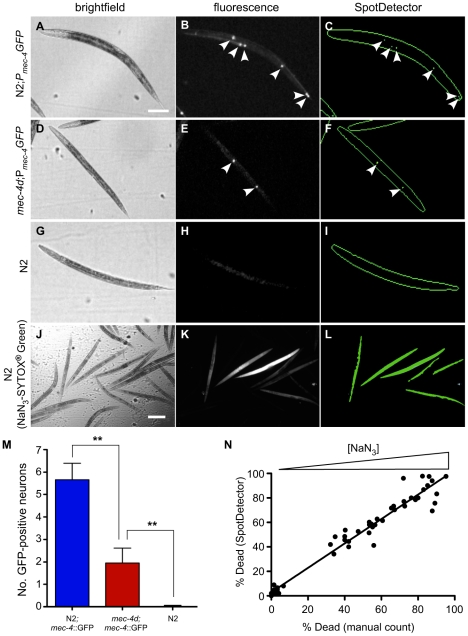
Identification of live cells or dead animals using C. elegans.The ArrayScan VTI and SpotDetector BioApplication was used to discriminate between wild-type and toxic gain-of-function mec-4(d) mutants based on the survival of the 6 mechanosensory neurons in C. elegans. Brightfield (left), fluorescence (center) and SpotDetector rendered (right) images are depicted for each line. (A–C, M) In N2 (wild-type) animals, Pmec-4GFP expression was evident within 5.7±0.7 touch-sensing neurons (arrowheads). (D–F, M) In the mec-4(d) mutant background, the number of Pmec-4GFP expressing neurons (arrowheads) was significantly reduced and averaged 2.0±0.7 neurons per animal. (G–I, M) No GFP-positive neurons were identified in non-transgenic, N2 worms. Data derived from minimum of 32 wells containing ∼20 animals/well. Statistical significance determined using the Student's t-test, **P<0.001. The system was then used to discriminate live from dead animals. (J–L) Adult worms expressing the pharyngeal marker, Pmyo-2mRFP, were incubated with various concentrations of NaN3, stained with SYTOX® Green and imaged using the ArrayScan VTI (J–K). The SpotDetector BioApplication was optimized to determine the percentage of dead animals by counting the number of SYTOX® Green -positive bodies (L) and dividing by the total number of Pmyo-2mRFP-positive heads (not shown) detected in the GFP and TRITC fluorescence channels, respectively. (N) Percentage of dead animals at different NaN3 concentrations as determined by visual inspection versus that determined by SpotDetector. The slope and goodness-of-fit (r
2) of the linear regression were 1.0 and 0.95, respectively. The slope of the line was not significantly different to 1 indicating near 1∶1 correlation (P>0.95). Scale bars, 100 µm (A–I), 225 µm, (J–L).